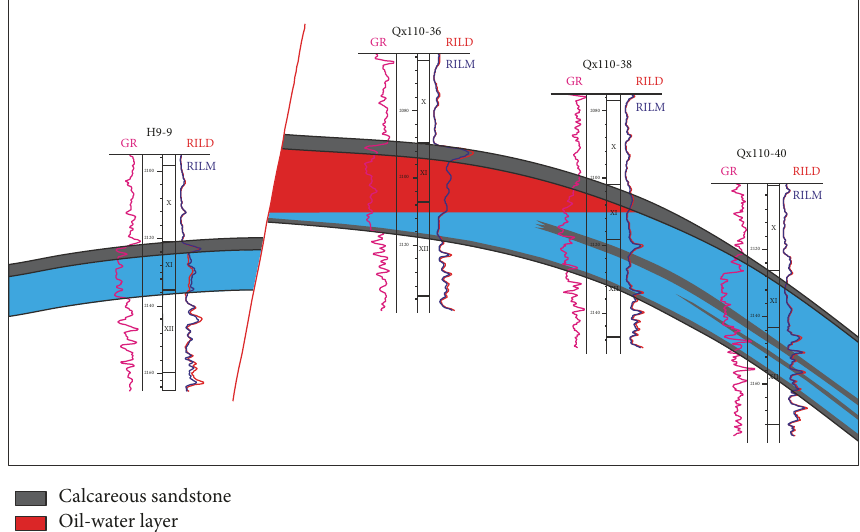
Figure 11: Reservoir profile of H9-9 ∼ Qx110-40 at Daqingzijing area. The thickness of the middle amplitude curve segment is the oil layer thickness.